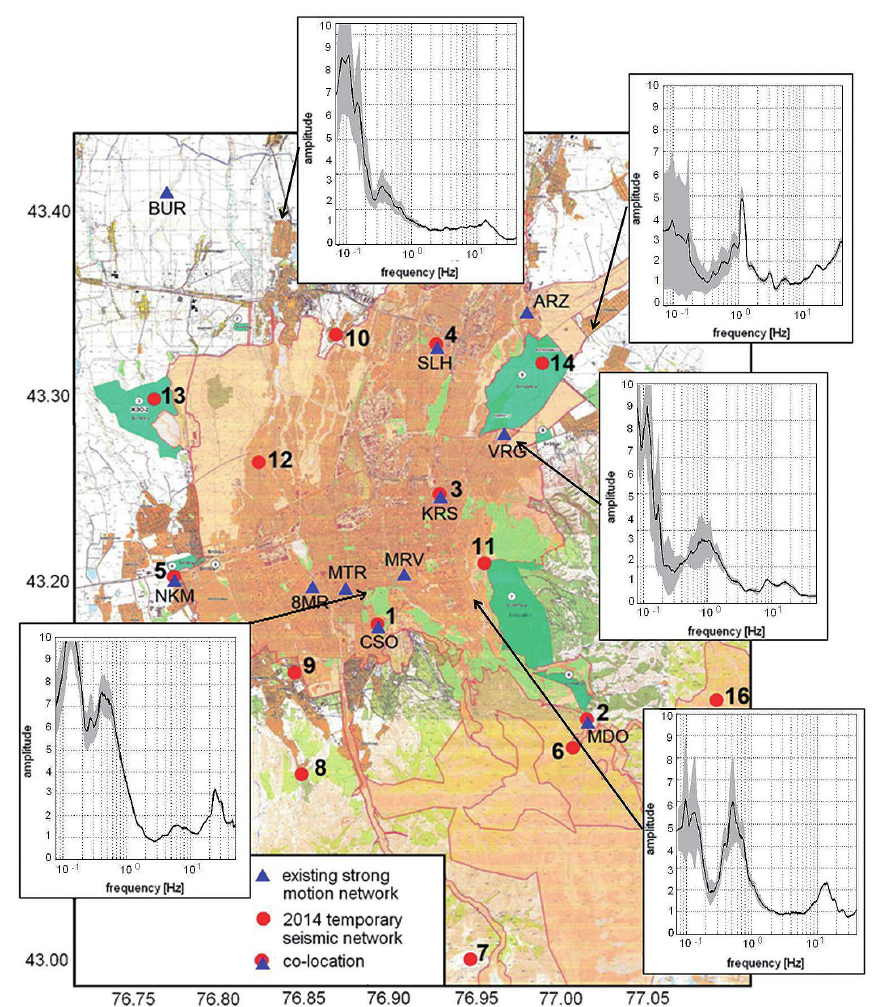
Figure 8. Network layout indicating the location of the existing strong motion stations (blue triangles) and weak motion stations (red dots) in the city of Almaty. The embedded images show the noise H/V spectral ratio plus/minus one standard deviation for representative sites in the city. The reddish color shows the actual administrative border of the city. The greenish areas will be incorporated in the